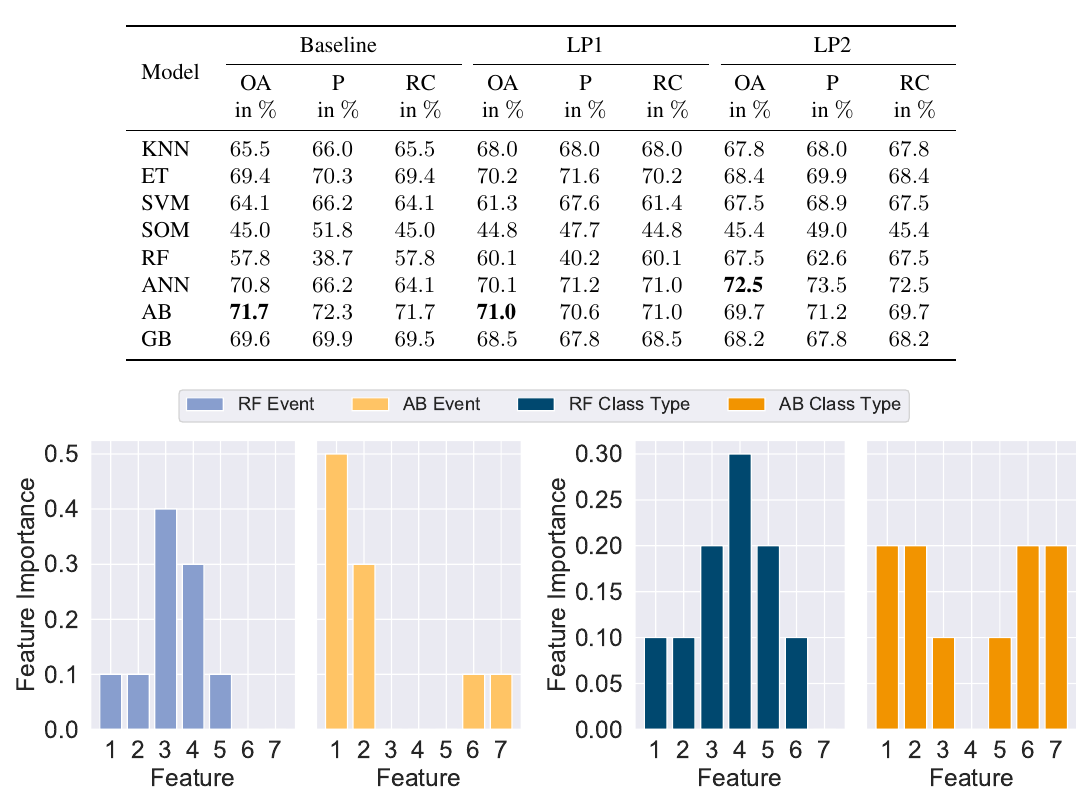
Table 5. Overview of the results of the class type classification for the ML models under consideration. The classification performance is expressed by the overall accuracy (OA), precision (P) and recall (RC). The highlighted figures represent the best classification results for each preprocessing approach.